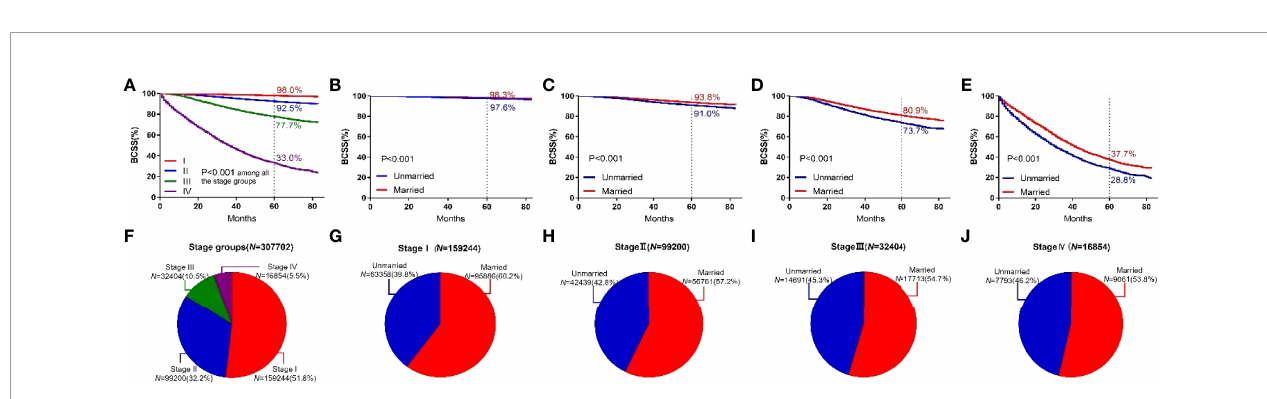
FIGURE 5 | BCSS curves according to the stage groups. (A) and subject proportions of the stage groups (F) . Survival curves of each marital status for stage I (B) , stage II (C) , stage III (D) and stage IV (E) and subject proportions of each marital status for stage I (G) , stage II (H) , stage III (I) and stage IV (J) were